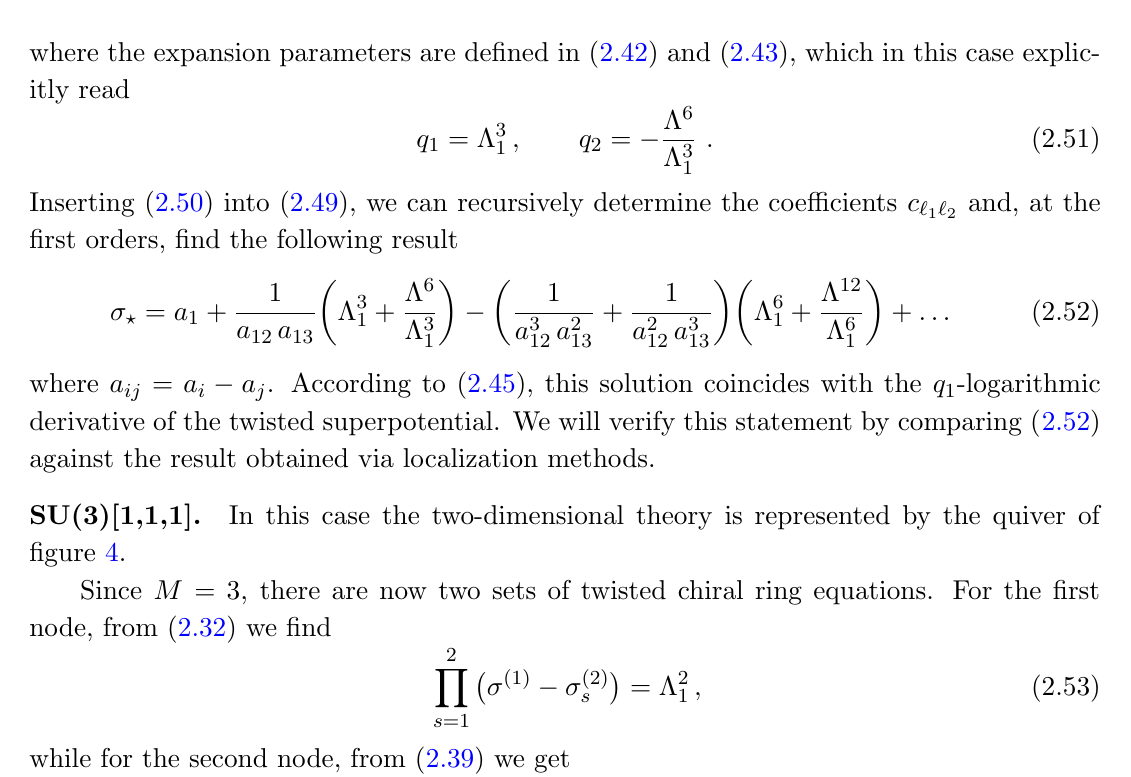
Figure 4 . The quiver diagram representing the surface operator